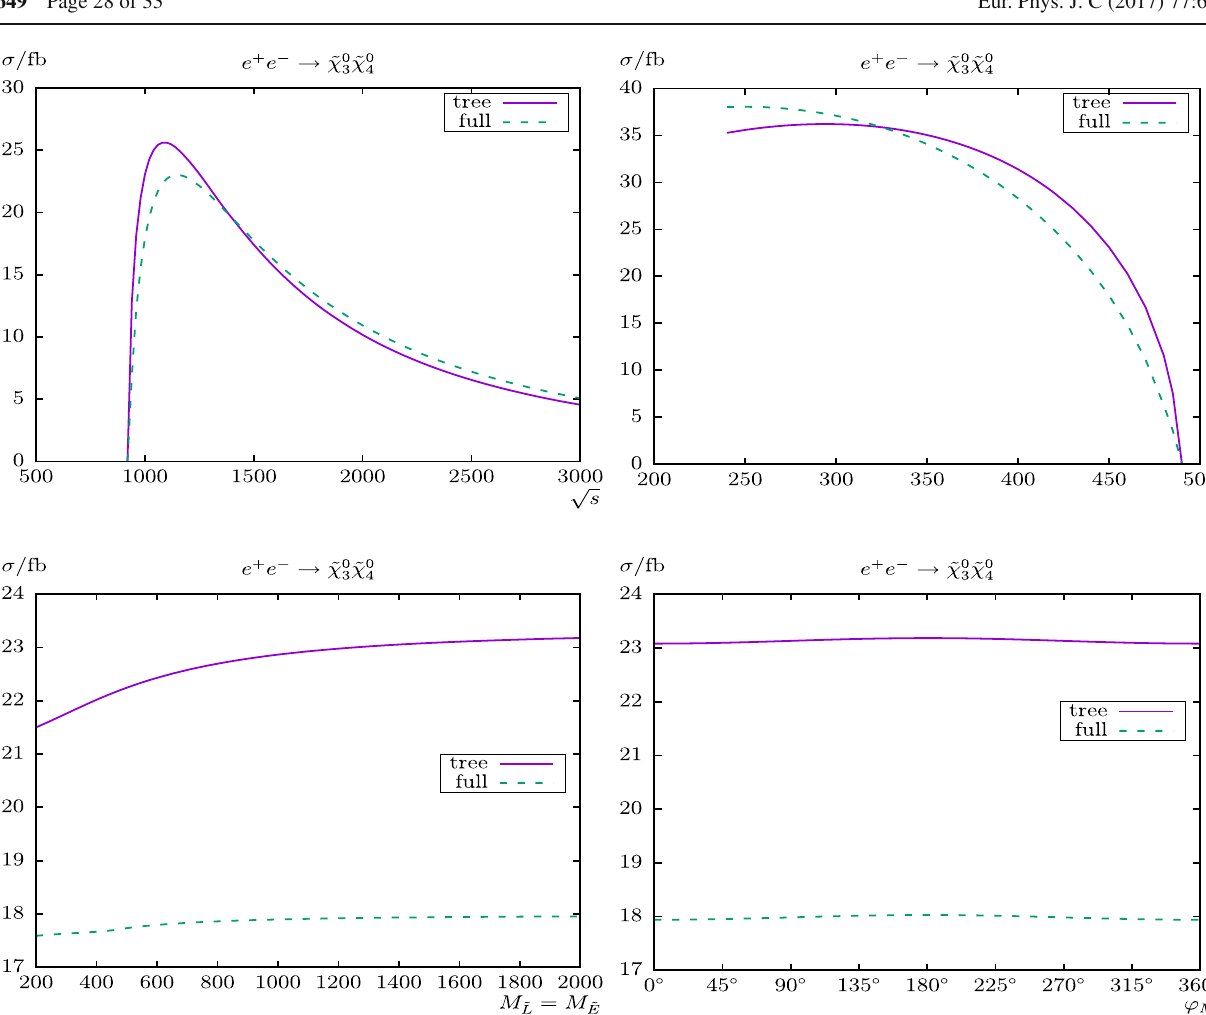
Fig. 25 σ( e + e − → ˜ χ 0 The upper plots show the cross sections with